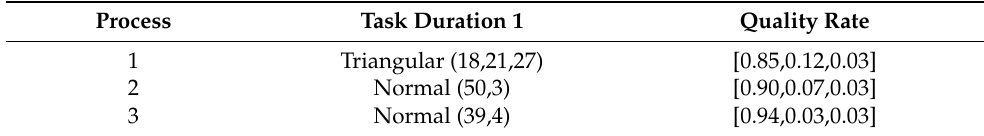
Table 1. List of the selected process characteristics.